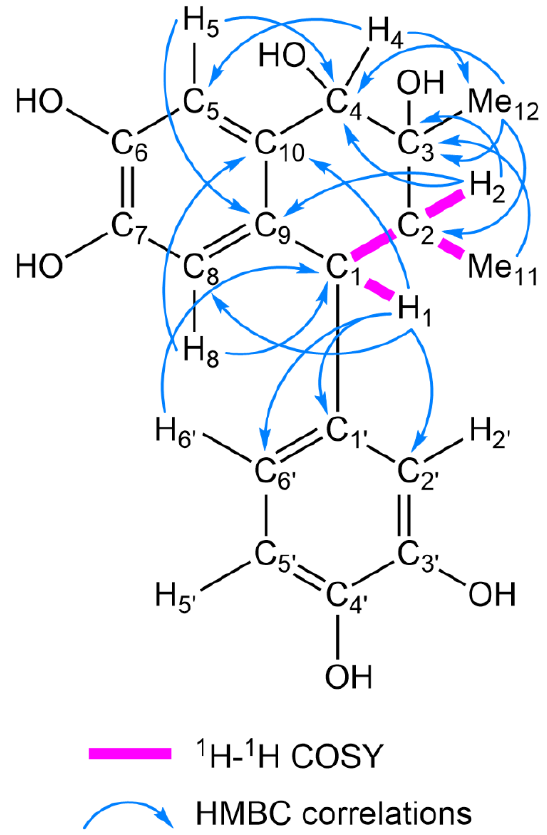
Figure 2. 1 H- 1 H COSY and key HMBC correlations of 4 .